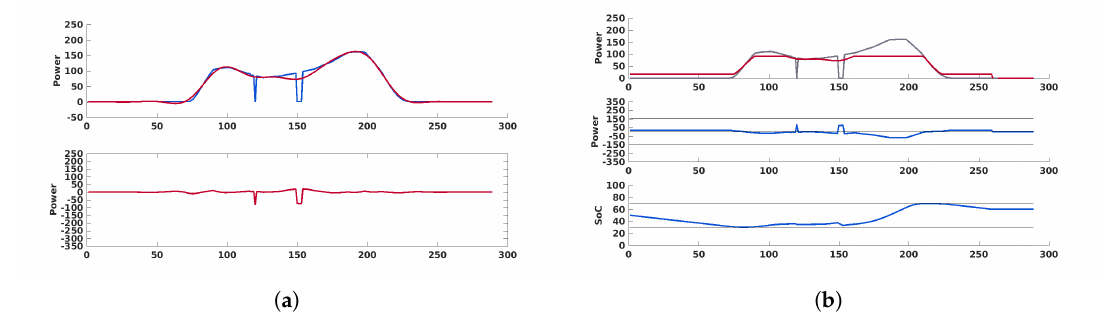
Figure 4. ( a ) Top: forecast power profile (blue), filtered power profile (red). Bottom: Ideal battery power needed to let flowing to the grid a power equal to the filtered one; ( b ) Top: Forecast power profile ( P hcpv , grey), power profile after application of FBM ( P g , red); Middle: battery power evolution ( P ess ); Bottom: battery